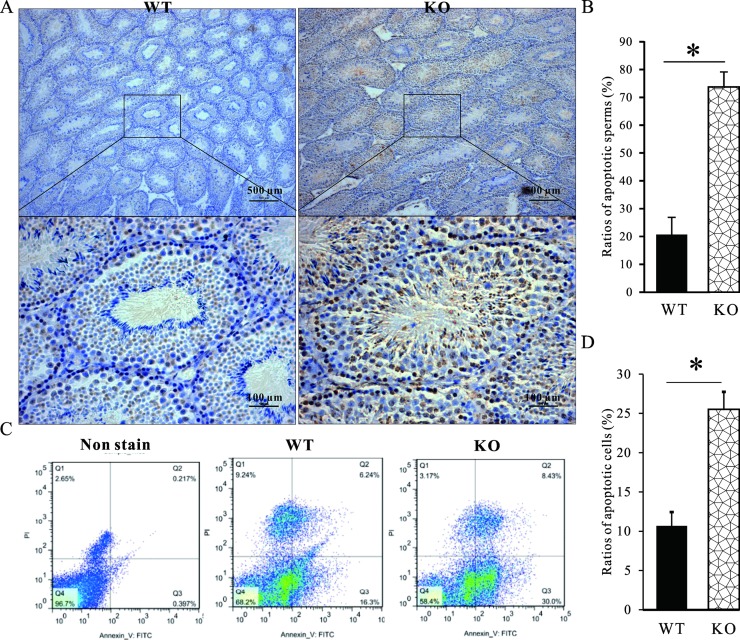
Deficiency of MTMR14 induced apoptosis and autophagy in testis.(A) Sections of testes from age-matched WT and MTMR14-/- mice were used to perform the TUNEL assay. (B) The proportions of positive apoptotic cells in (A) were calculated using Image-Pro Plus software, version 6.0. *: P < 0.05. (C) The spermatozoa from WT and MTMR14-/- littermate testes were collected and then were stained with Annexin V/PI and analysed by flow cytometry to determine the apoptotic proportions. No stained spermatozoa from WT mice were used as controls. The results of four separate experiments were very similar. Representative images of flow cytometry for the spermatozoa were shown. (D) Summary of the proportions of apoptotic cells in (C) is presented in the bar charts (n = 4). *: P < 0.05. These data further support that MTMR14 participates in spermatogenesis in mice.